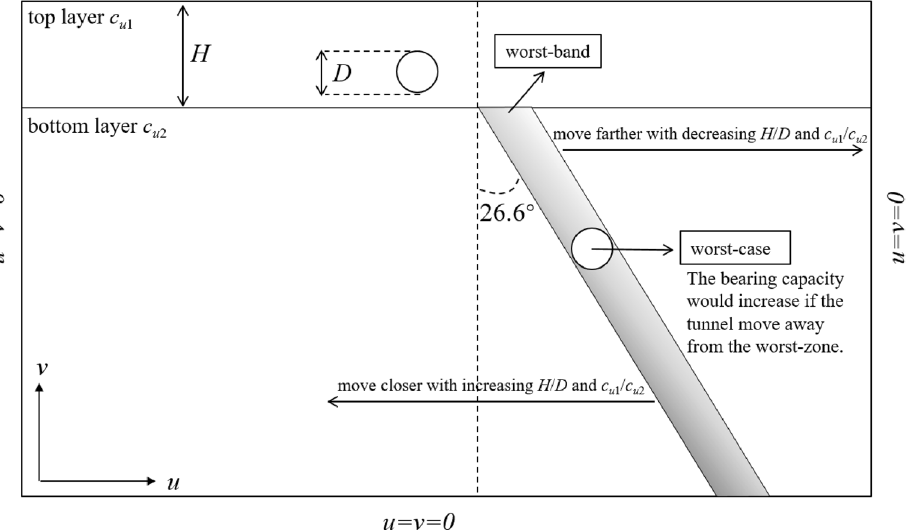
Figure 10. The sketch of the